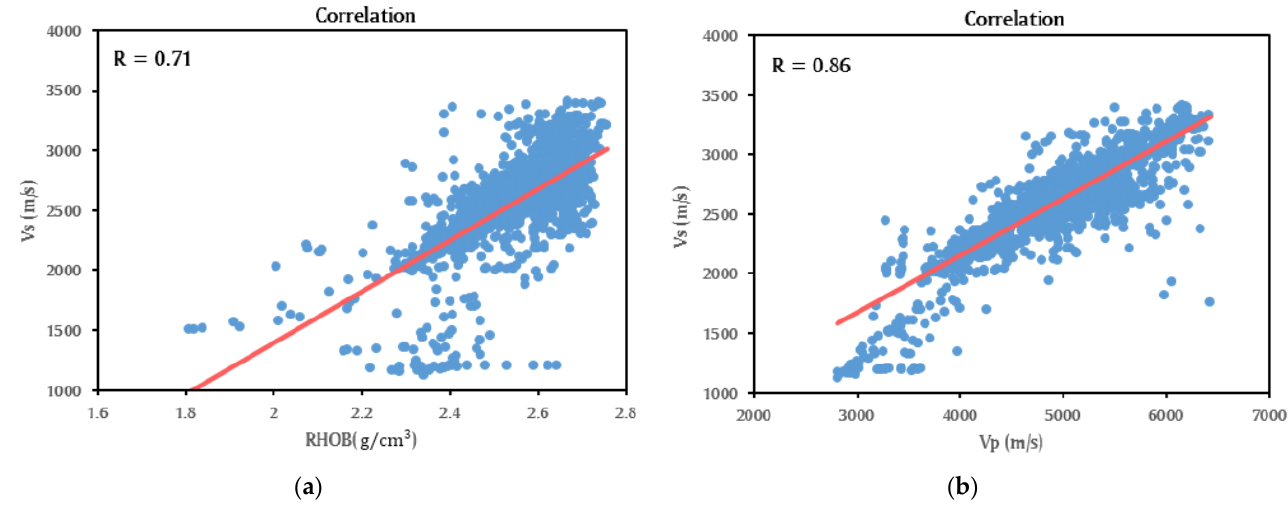
Figure 3. Well-logging data for input parameters in the study area ( a ) V P ; ( b ) RHOB; and ( c ) Vs.